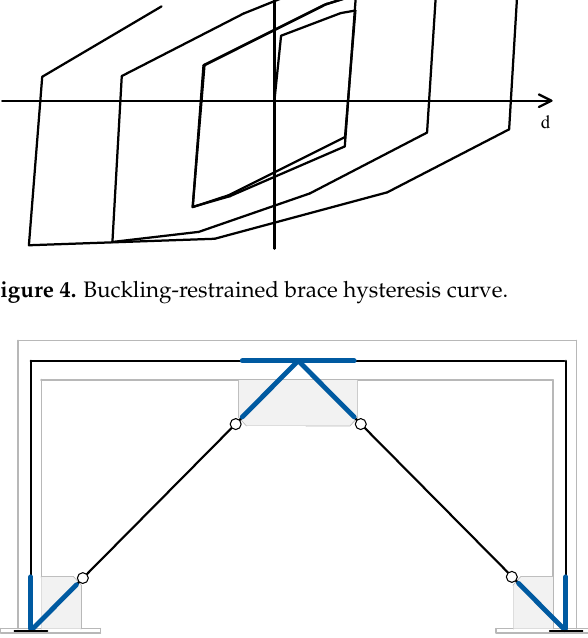
Figure 5. Rigid zone of the braced frame substructure.